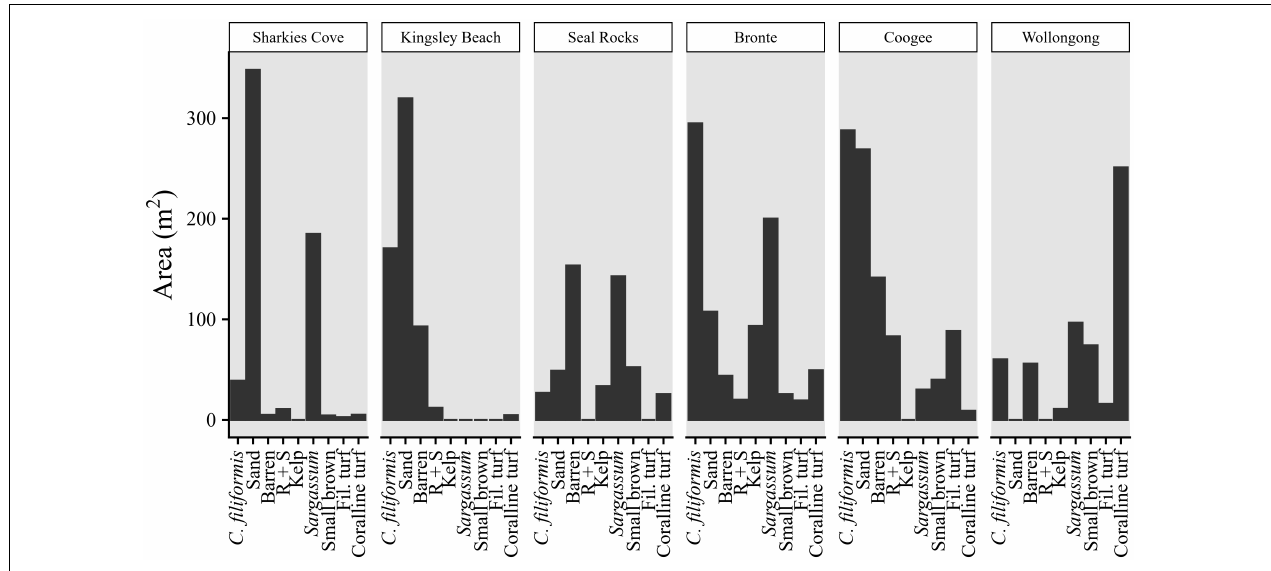
FIGURE 3 | Estimated habitat area surveyed at each site. Note that C. filiformis habitat refers to adult cover. See Table 1 for habitat descriptions.